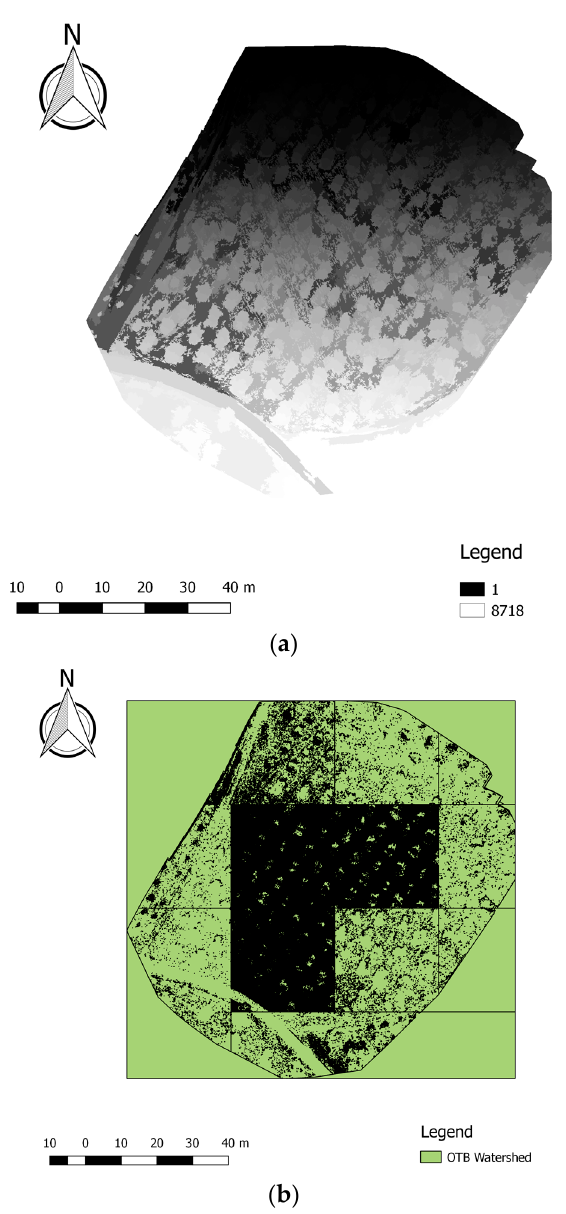
Figure 3. ( a ) Segmentation with i.segment algorithm; ( b ) segmentation with Watershed algorithm .